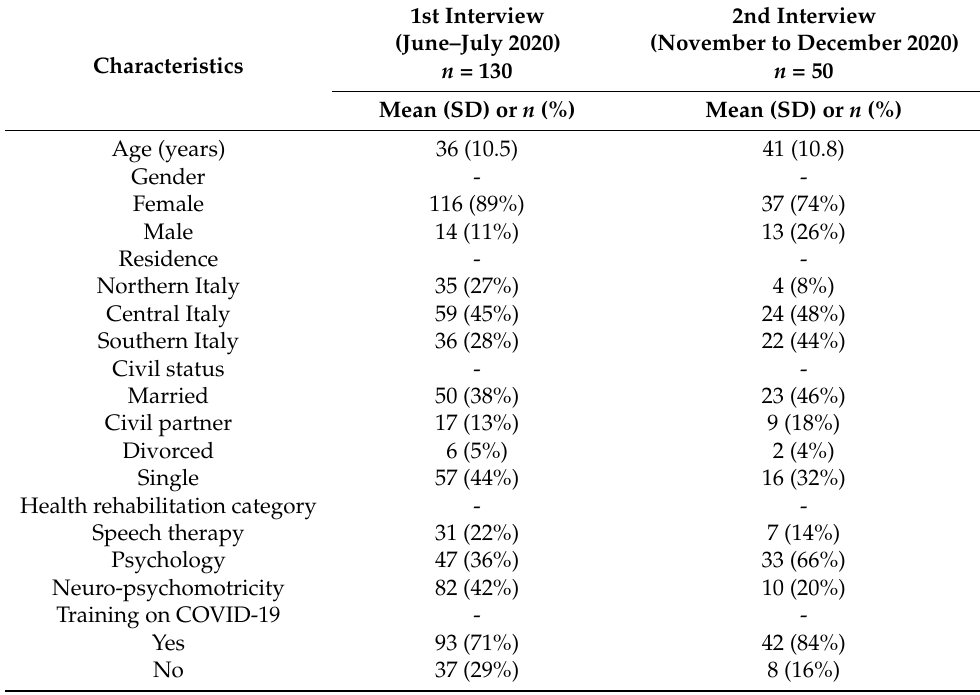
Table 1. Participants’ background parameters at the 1st and 2nd